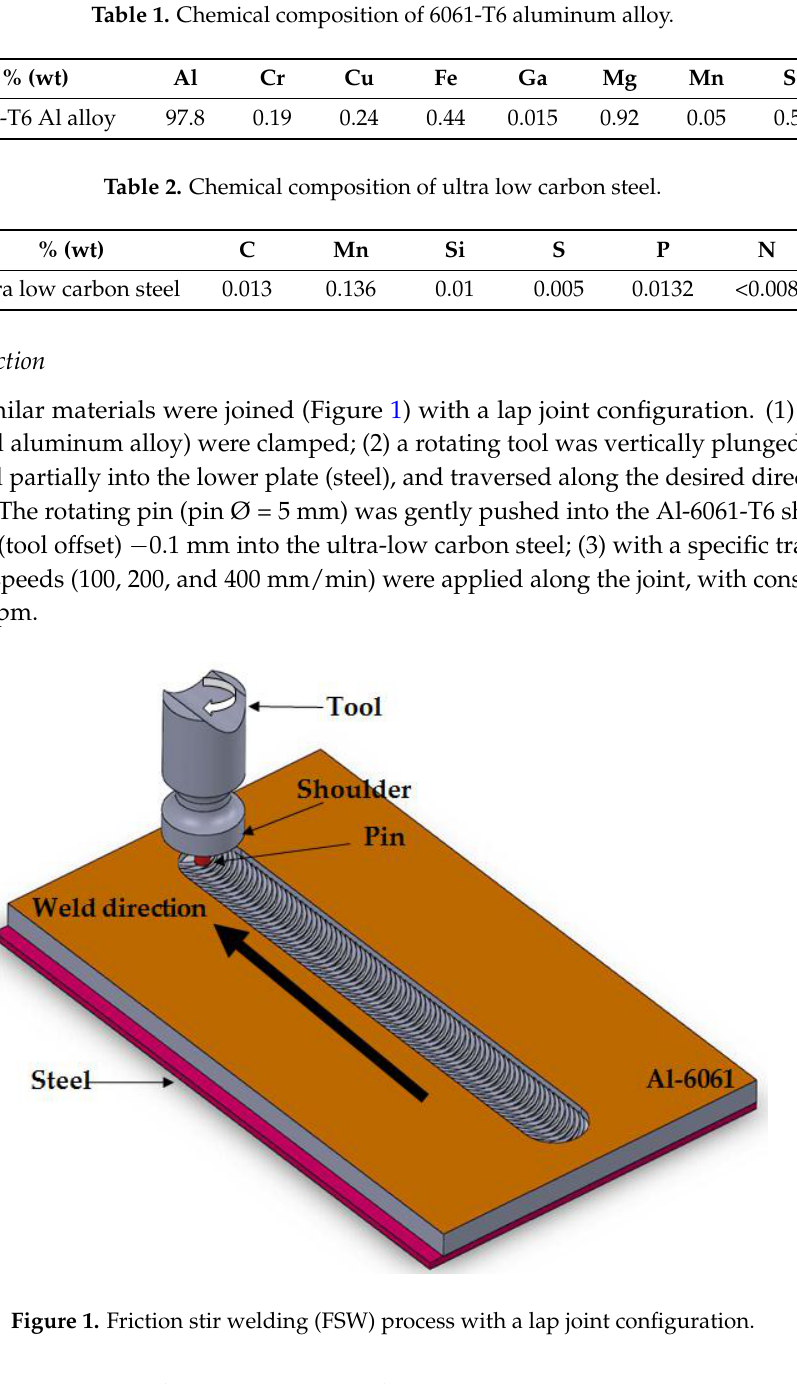
Table 1. Chemical composition of 6061-T6 aluminum alloy.